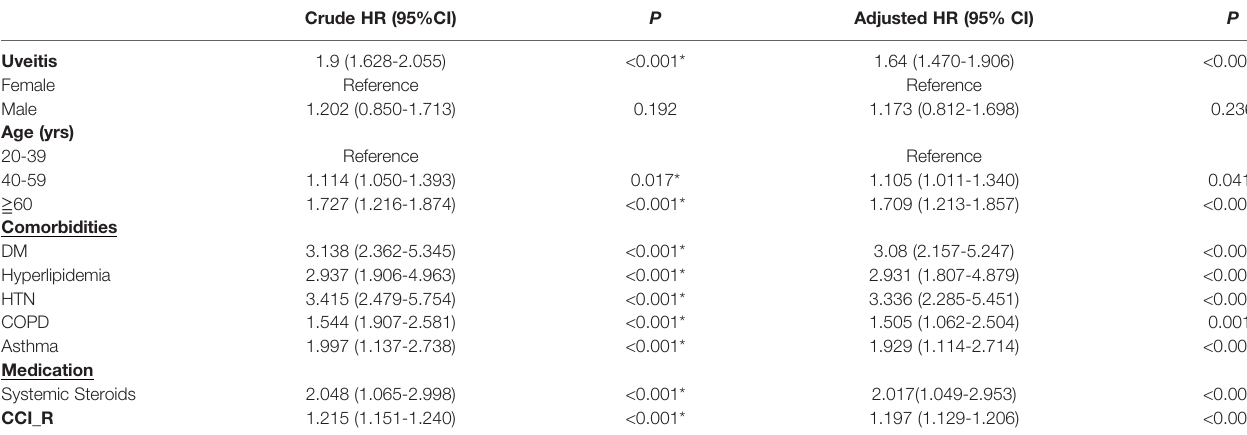
TABLE 2 | Factors of ACS by using Cox regression with Fine & Gray ’ s competing risk